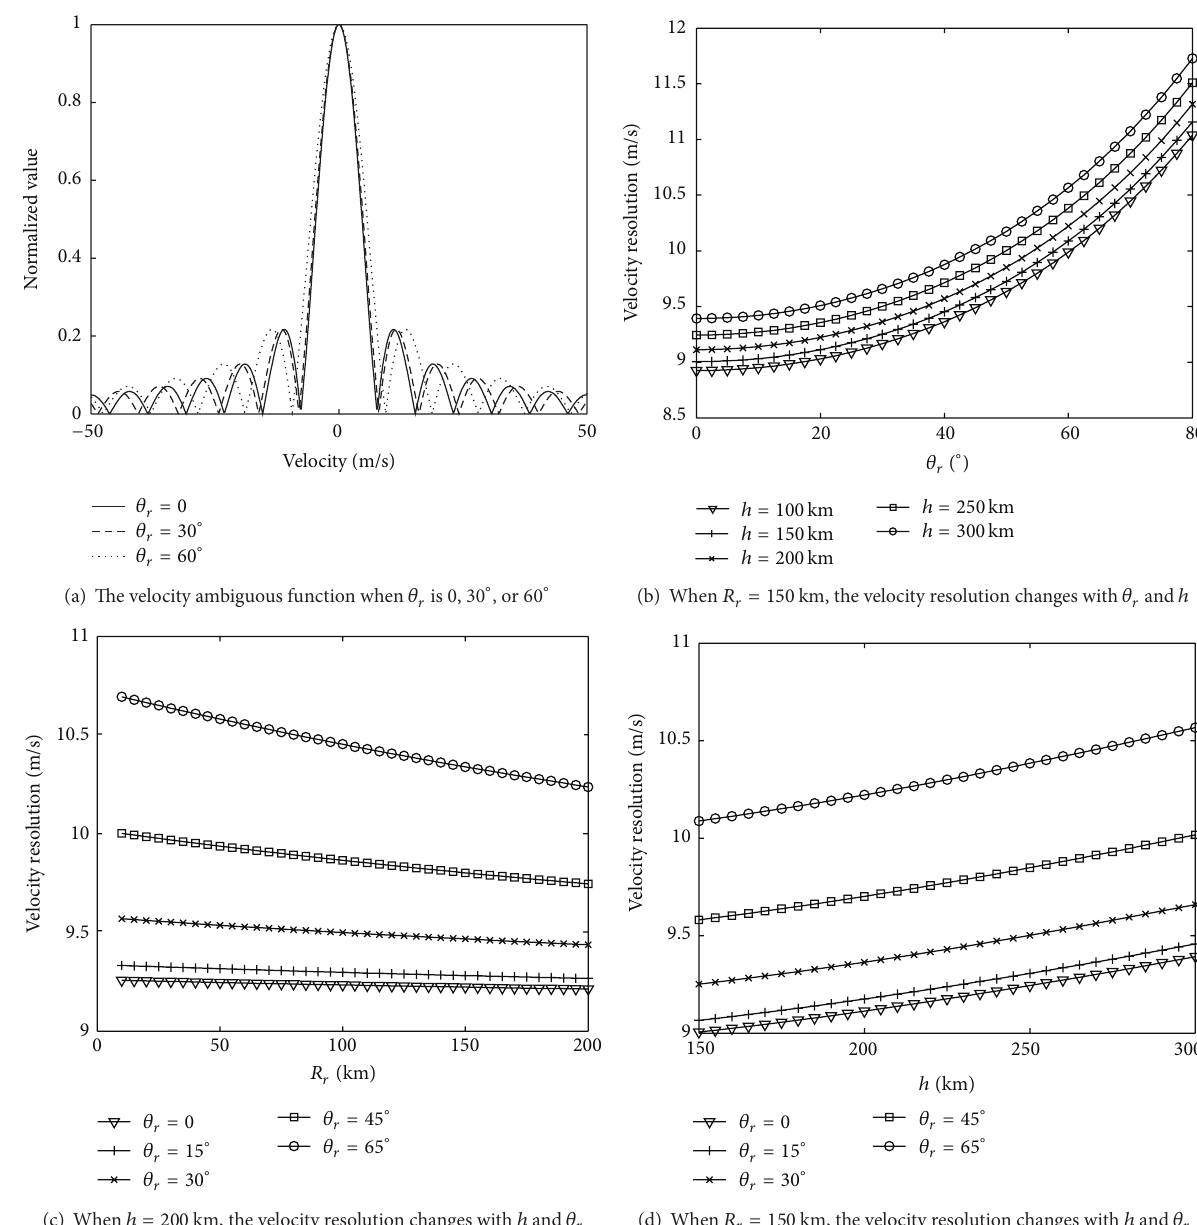
Figure 5: The ambiguous function and the velocity resolution of the hybrid